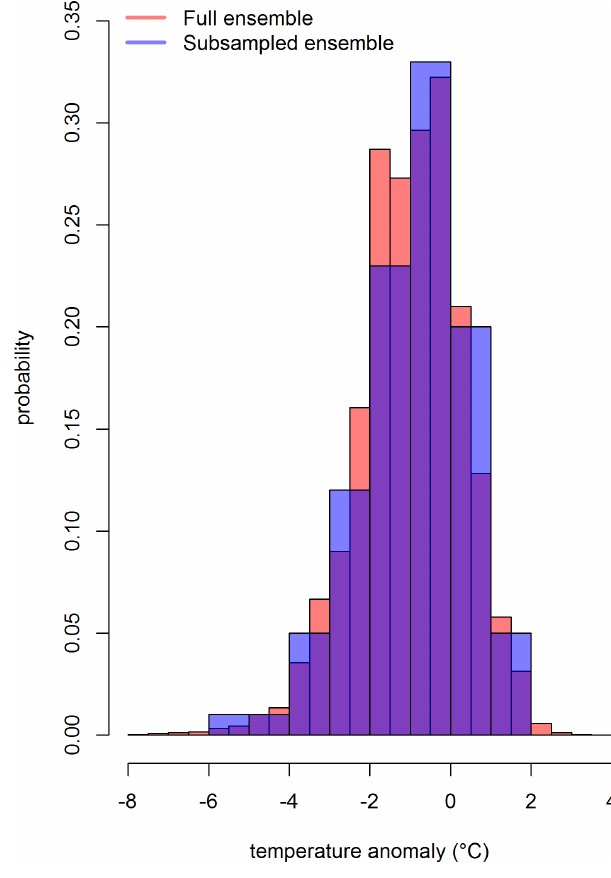
Figure 6. The distribution of the grid box (long and lat are 72 . 5 ◦ and 32 . 5 ◦ , respectively) that includes Lahore for May 1861. The full ensemble consists of 100000 grid boxes (Sect. 4.3), and the subsampled ensemble consists of 100 grid boxes based on Latin hypercube